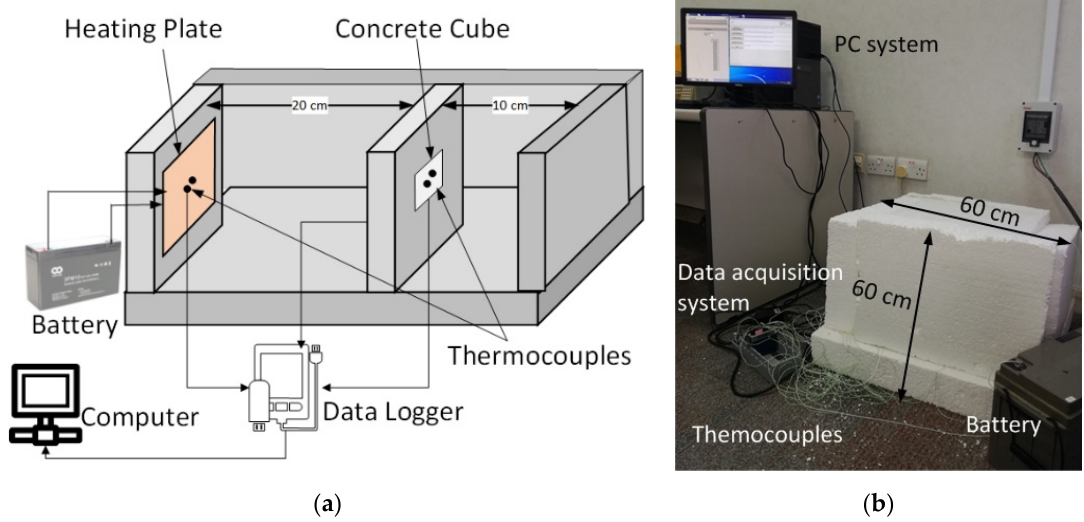
Figure 3. Experimental set-up for thermal performance measurement; ( a ) schematic diagram ( b ) original photo.